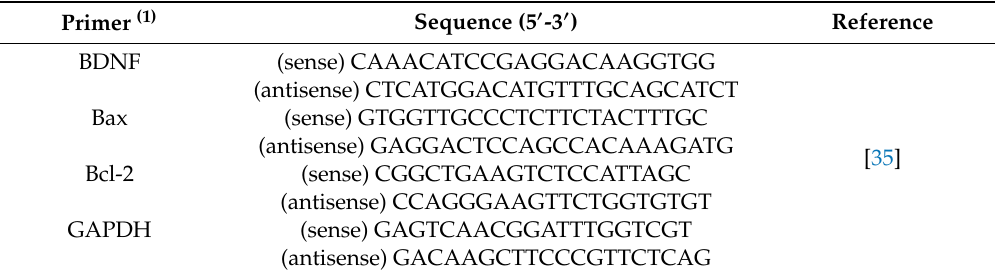
Table 5. Primer sequences related to the neuroprotective e ff ect used in real-time